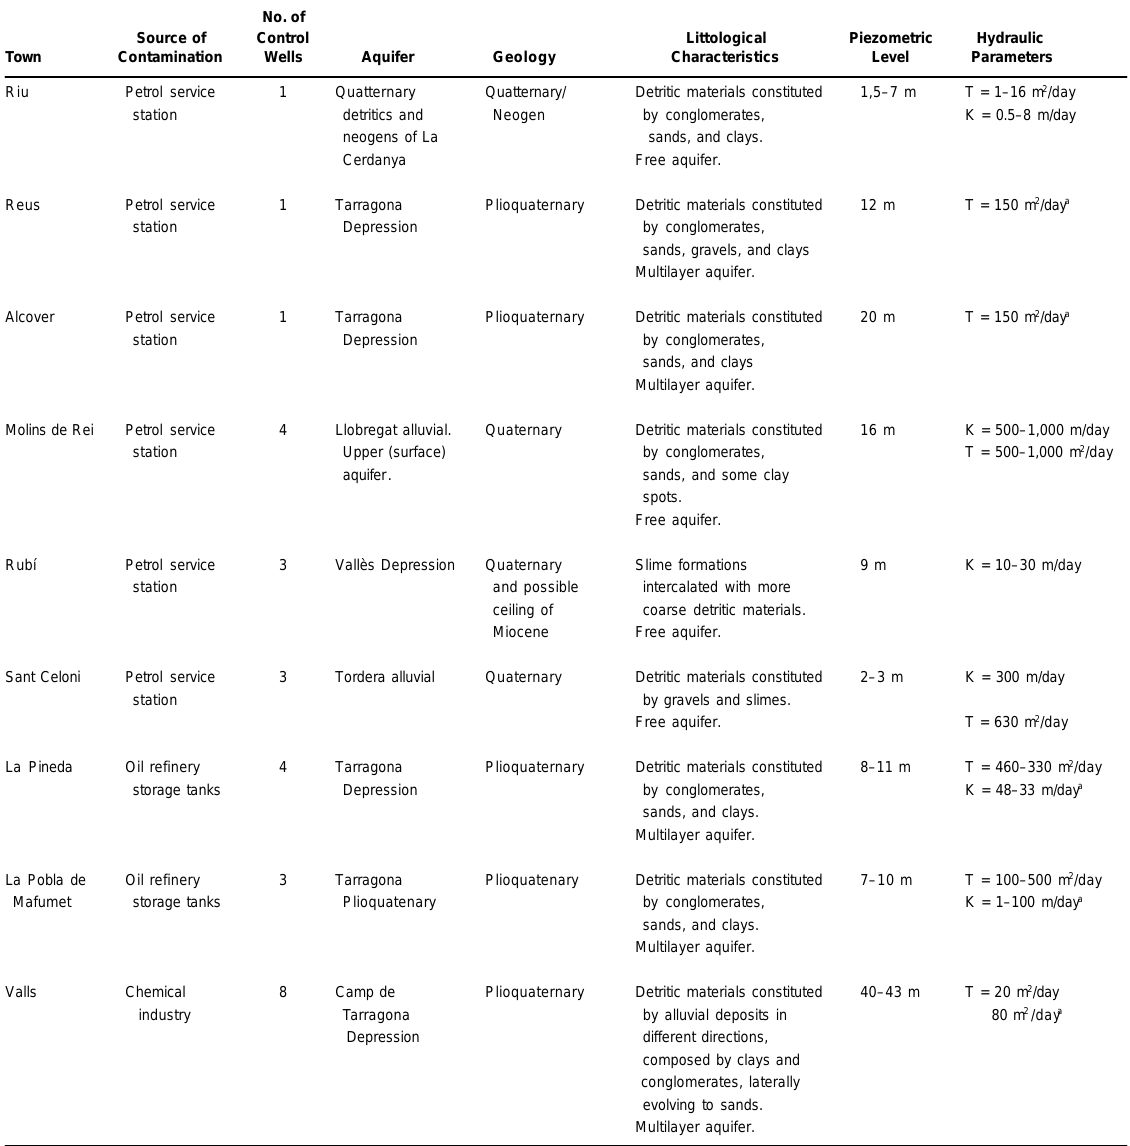
different directions, composed by clays and conglomerates, laterally evolving to sands. Multilayer